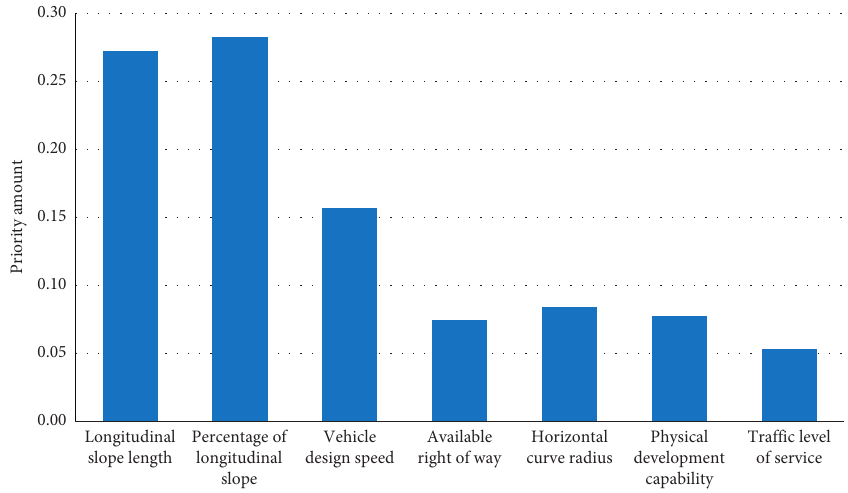
Figure 6: Representation of the prioritization of technical subcriteria. Table 7: Prioritizing the economic subcriteria.